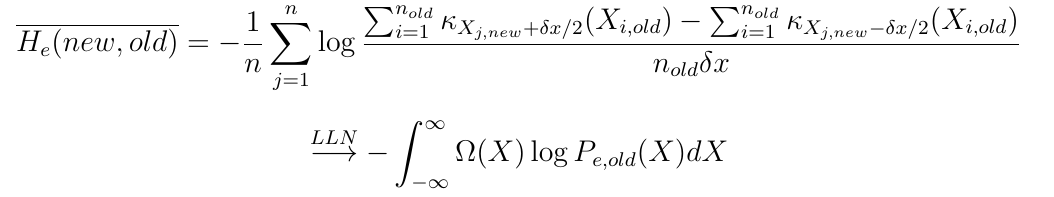
observations from the unit old